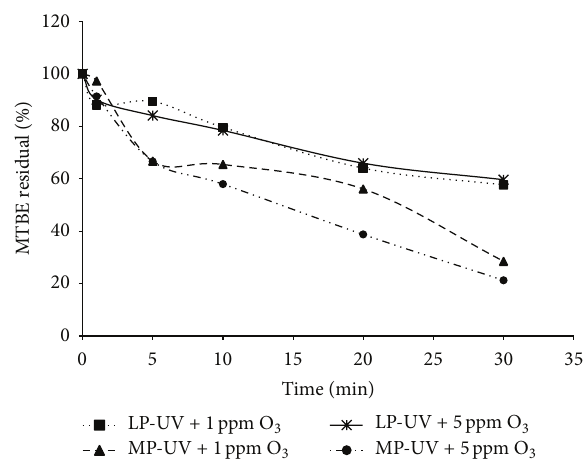
Figure 6: Removal of MTBE using UV/O 3 process.